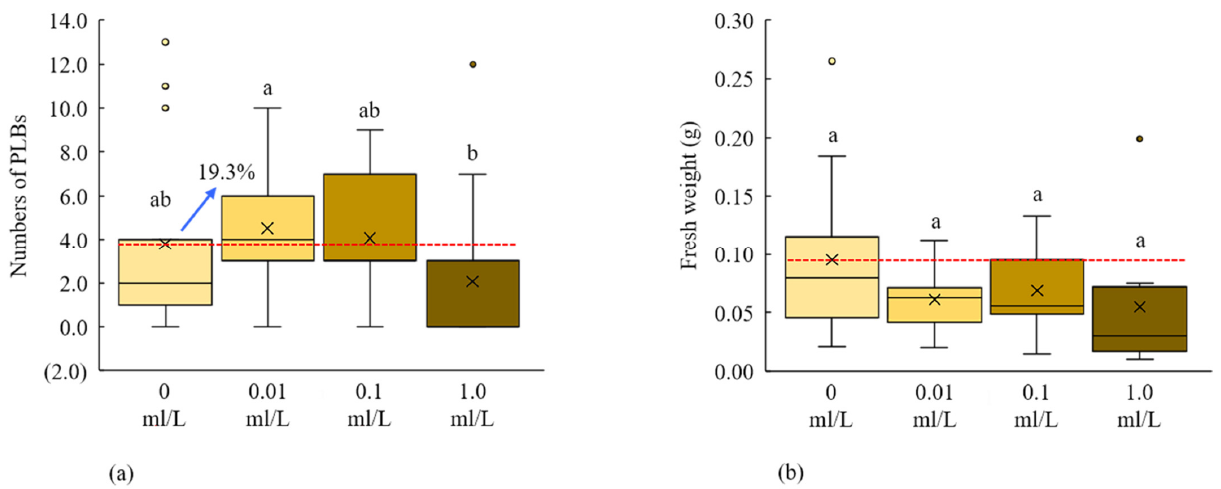
Figure 4. Response of different concentrations of HMI for the PLBs regeneration of D. okinawense on ( a ) the number of PLBs and ( b ) fresh weight. Crosses in the box represent the mean number of the newly regenerated PLB from the total explant ( n = 15). Red horizontal lines represent the mean value of control (0 ml/L).The blue arrow over the boxplot represents the percentage from red horizontal line. Boxplots that share a letter are statistically identical in Tukey’s multiple comparison test ( p ≤ 0.05).